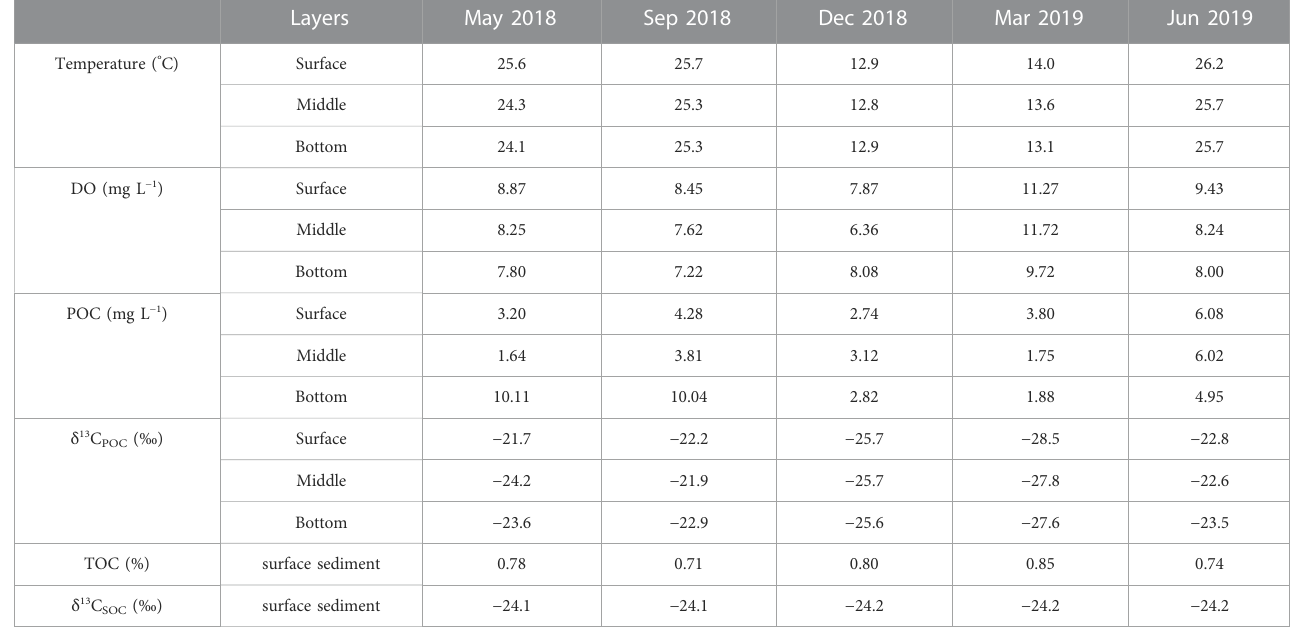
TABLE 1 Environment factors and bulk characteristics of particulate organic carbon (POC) and surface sedimentary organic carbon (SOC) in different layers.